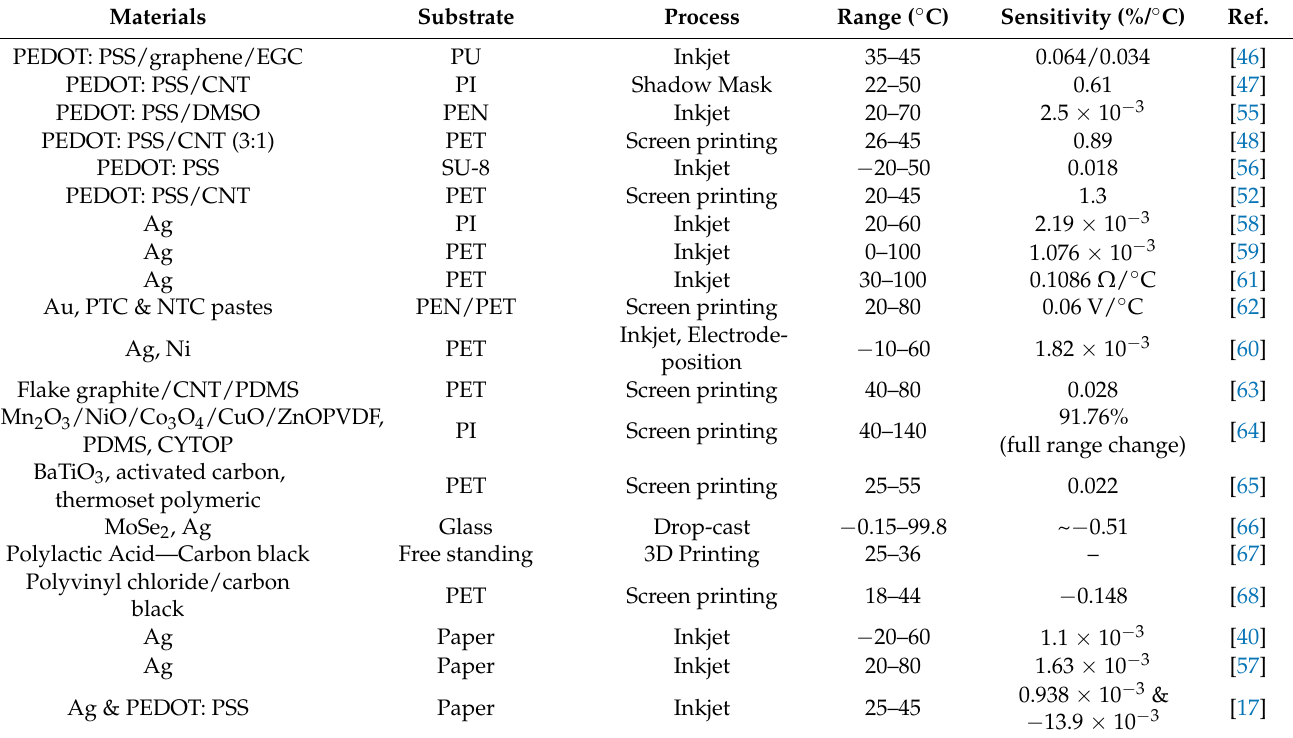
Table 4. Printed temperature sensors.